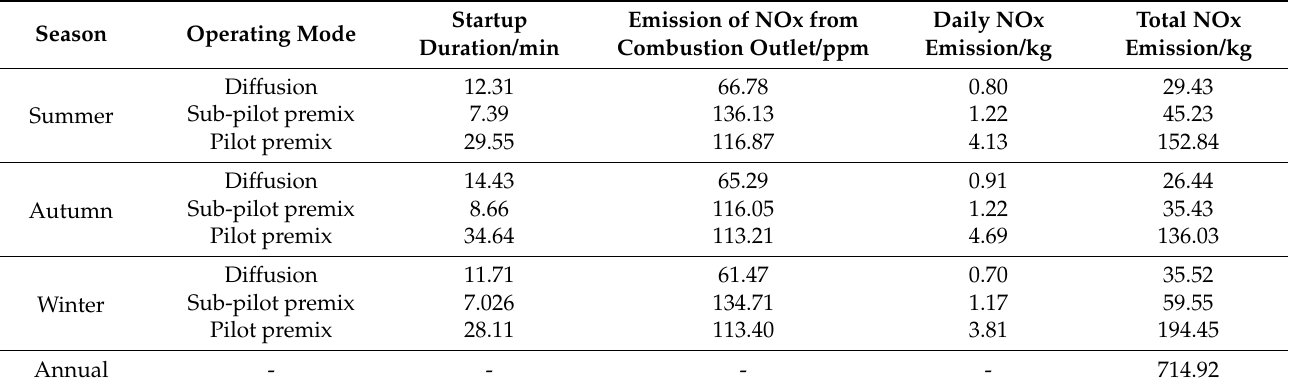
Table 8. Annual startup phase emission